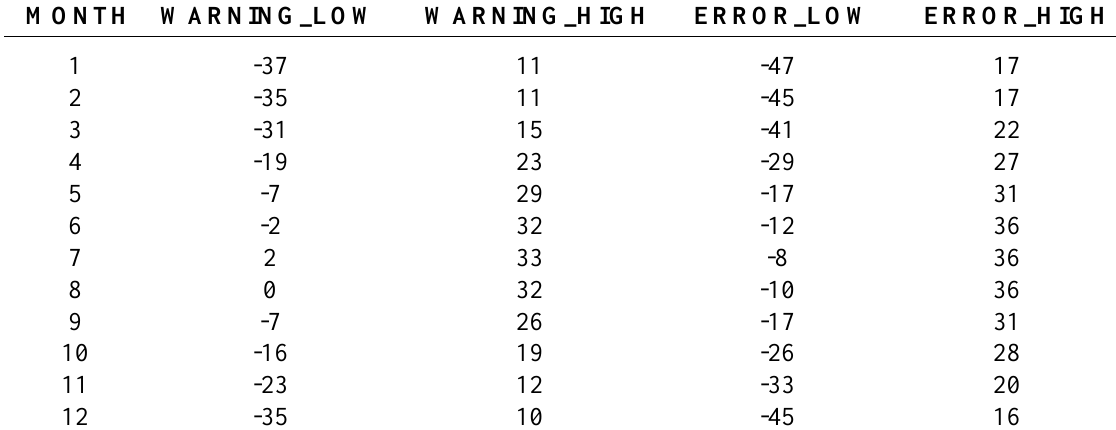
Table 2. The monthly range limits (ºC) for air temperature in hemiboreal climatic zone. Warning_low and warning_high denotes the range limits for suspicious values, error_low and error_high the range limits for meteorologically impossible